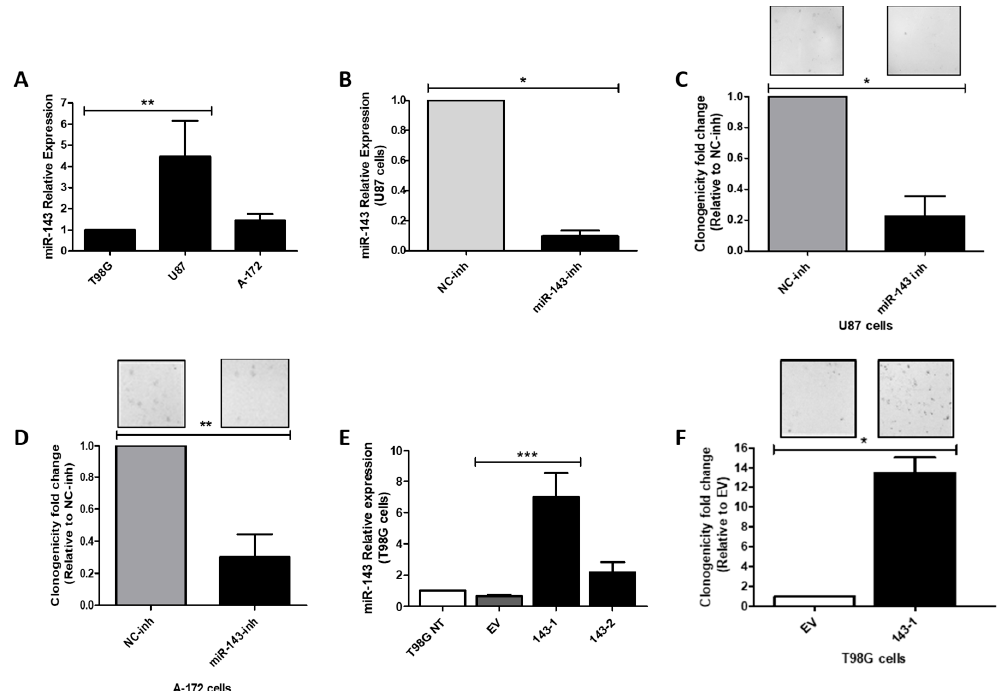
Figure 2. Effect of miR-143 inhibition or overexpression on cell proliferation. Total RNA was isolated, and qPCR was performed. ( A ) Relative miR-143 expression in a panel of Glioblastoma (GBM) cell lines, calculated relative to T98G cells; ( B ) Relative miR-143 expression after transient transfection of U87 with miR-inhibitors, calculated relative to the Negative control (NC) inhibitor. Colony formation assay after transfection of ( C ) U87 and ( D ) A-172 GBM cells with miR-143 inhibitor (miR-143-inh) or negative control inhibitor (NC-inh). ( E ) qPCR for relative miR-143 expression in empty vector (EV) and miR-143 T98G clones, calculated relative to the T98G non-treated (T98G NT) cells. ( F ) Colony formation assay of the T98G (143-1) miR-143 overexpressing clone and T98G Empty Vector (EV) clone. Columns represent the means of at least triplicates ± SEM (* p < 0.05, ** p < 0.01, *** p <